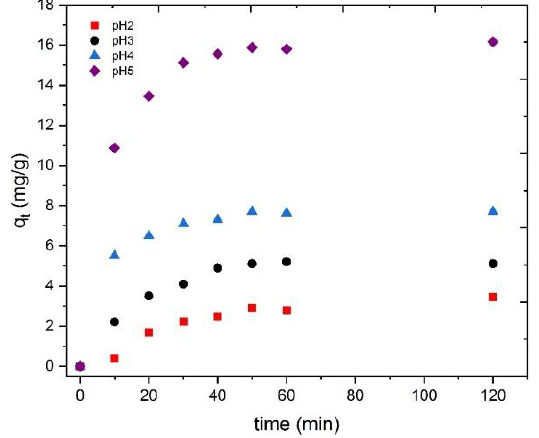
ff erent times tested.